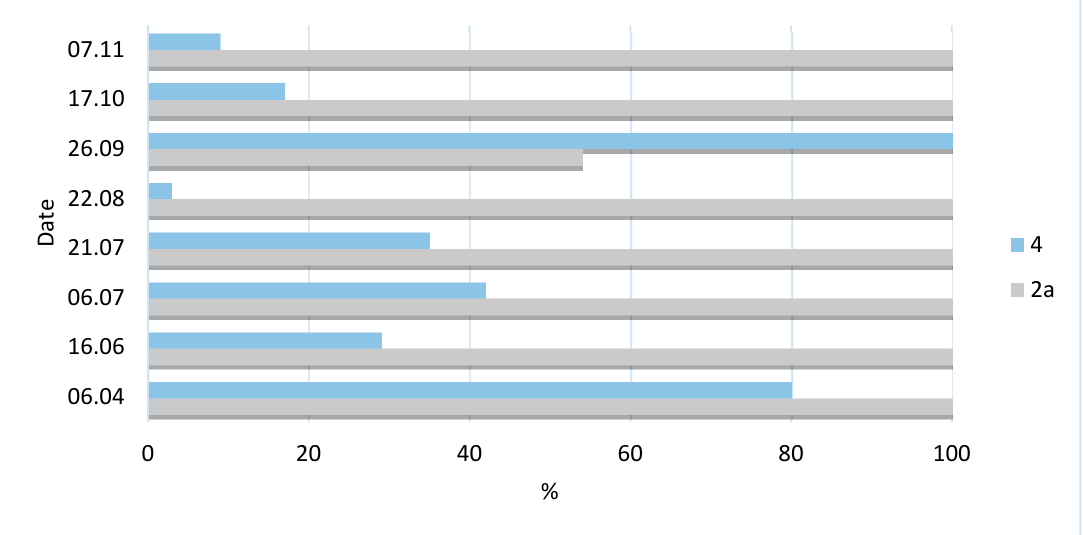
Figure 8. Efficiency of the SED-BIO system in reducing the number of E. coli cells. A decrease in the number in point 4 (outlet) in relation to point 2a (sedimentation segment). The result is shown as a percentage.